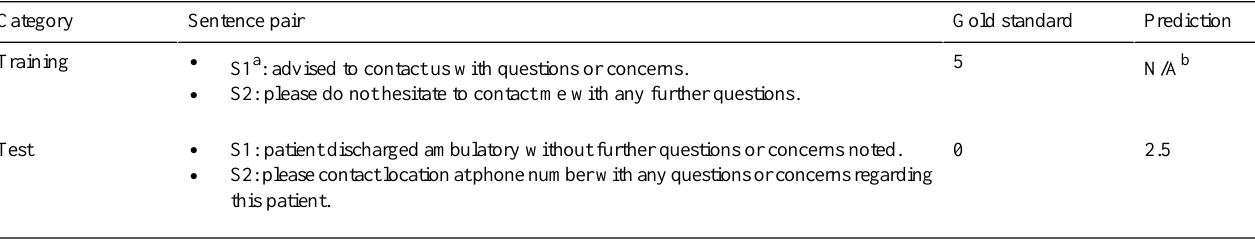
Table 4. Transformer model attention visualization on two examples from STS-Clinic.